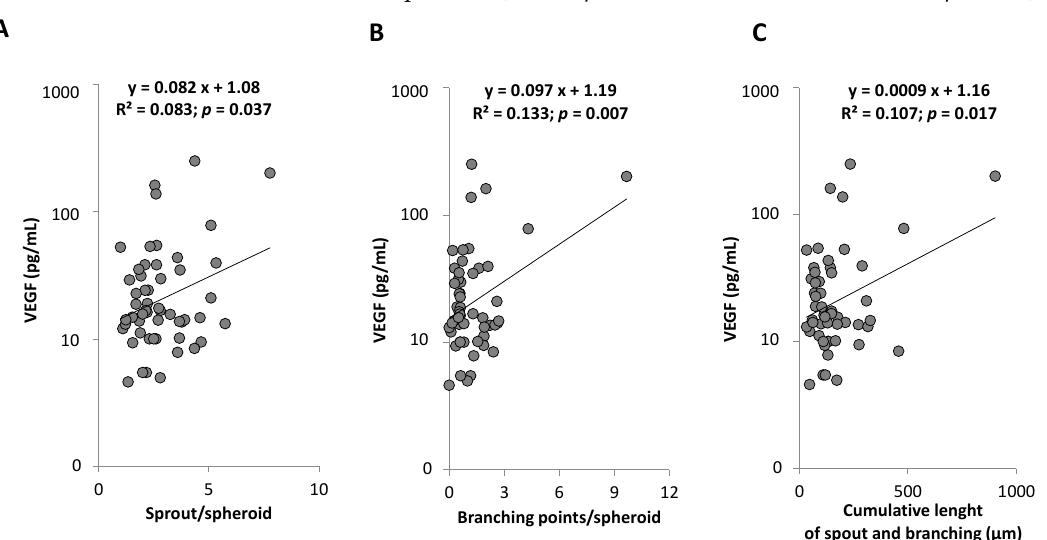
Figure 6. Relation between VEGF level and angiogenic function of ECFC. ( A ) VEGF level accord- ing to the number of sprouts per spheroid ( B ) VEGF level according to the number of branching points per spheroid ( C ) VEGF level according to the cumulative length per spheroid. R 2 and p are from Pearson correlation. VEGF indicates vascular endothelium growth factor.